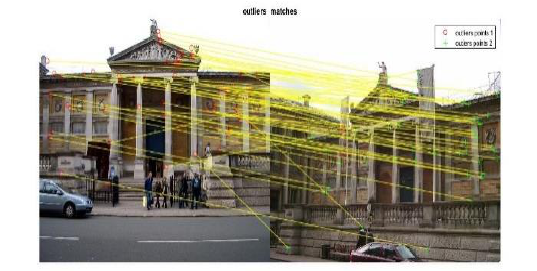
Figure 7. The impact of the threshold